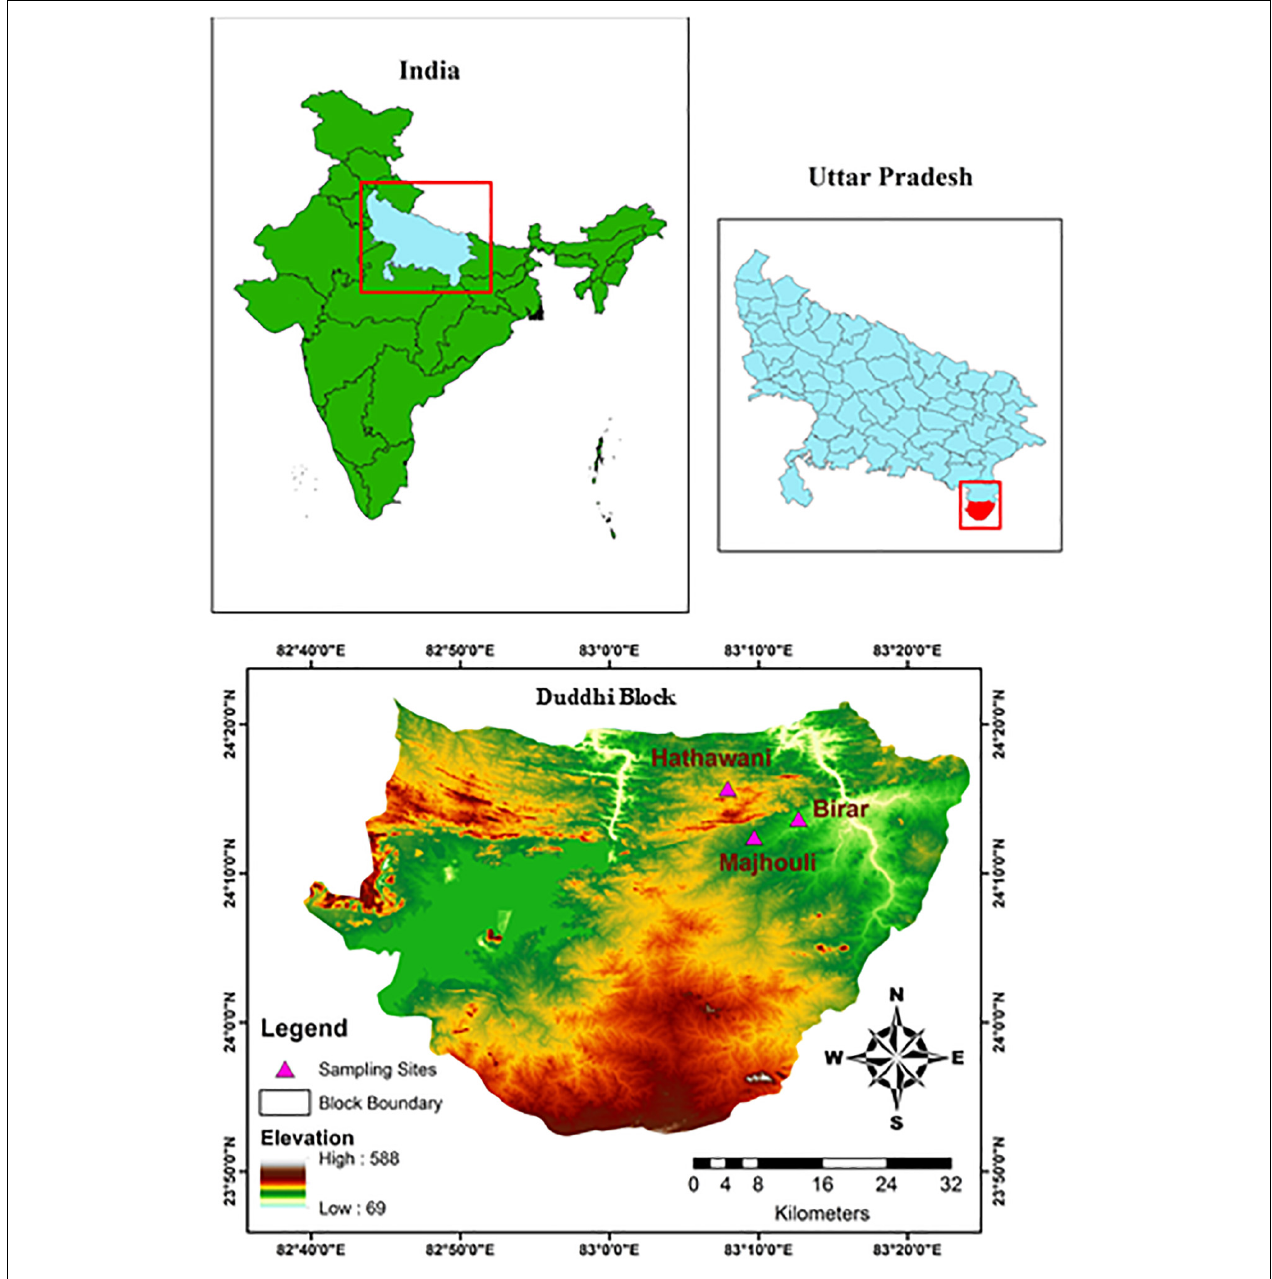
FIGURE 1 | Geographical location showing three study villages (Hathawani, Majhouli, Birar) in a dry tropical region of Vindhyan highlands,